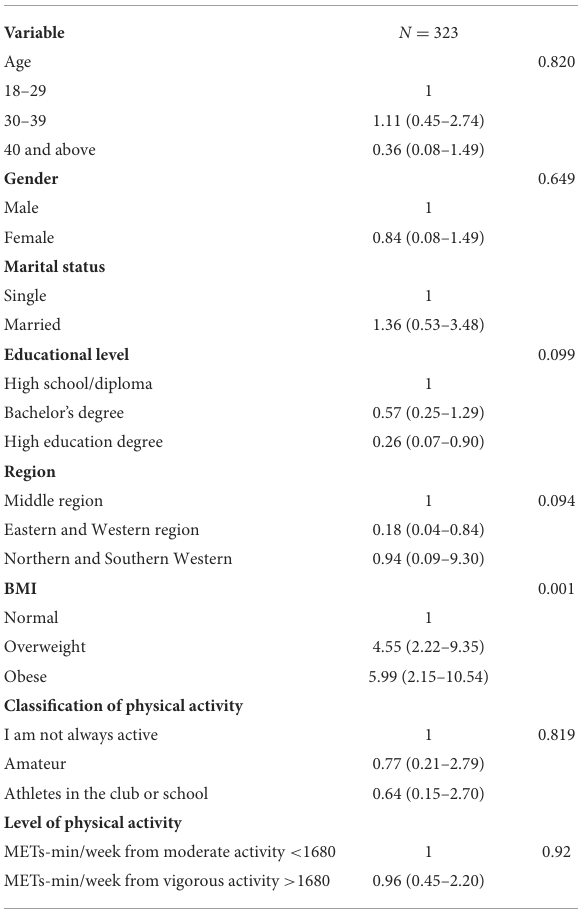
TABLE 3 Predictors associated with body dissatisfaction among physically active